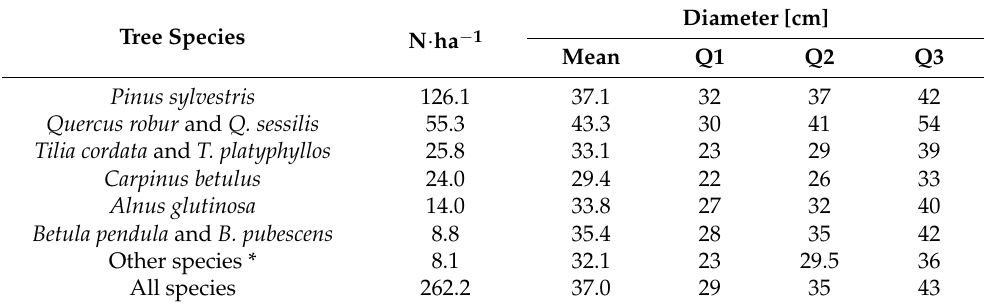
Table 1. Characteristics of tree stands over all 94 plots.